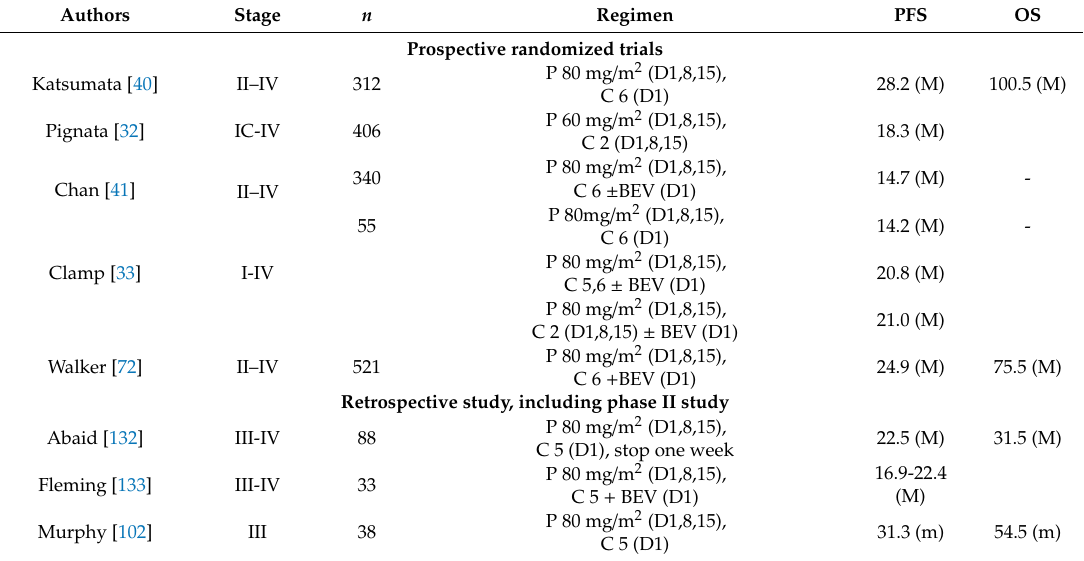
Table 5. Summary of treatment e ffi cacy and safety of dose-dense weekly paclitaxel plus platinum compounds in the management of patients with epithelial tubo-ovarian cancer and primary peritoneal serous